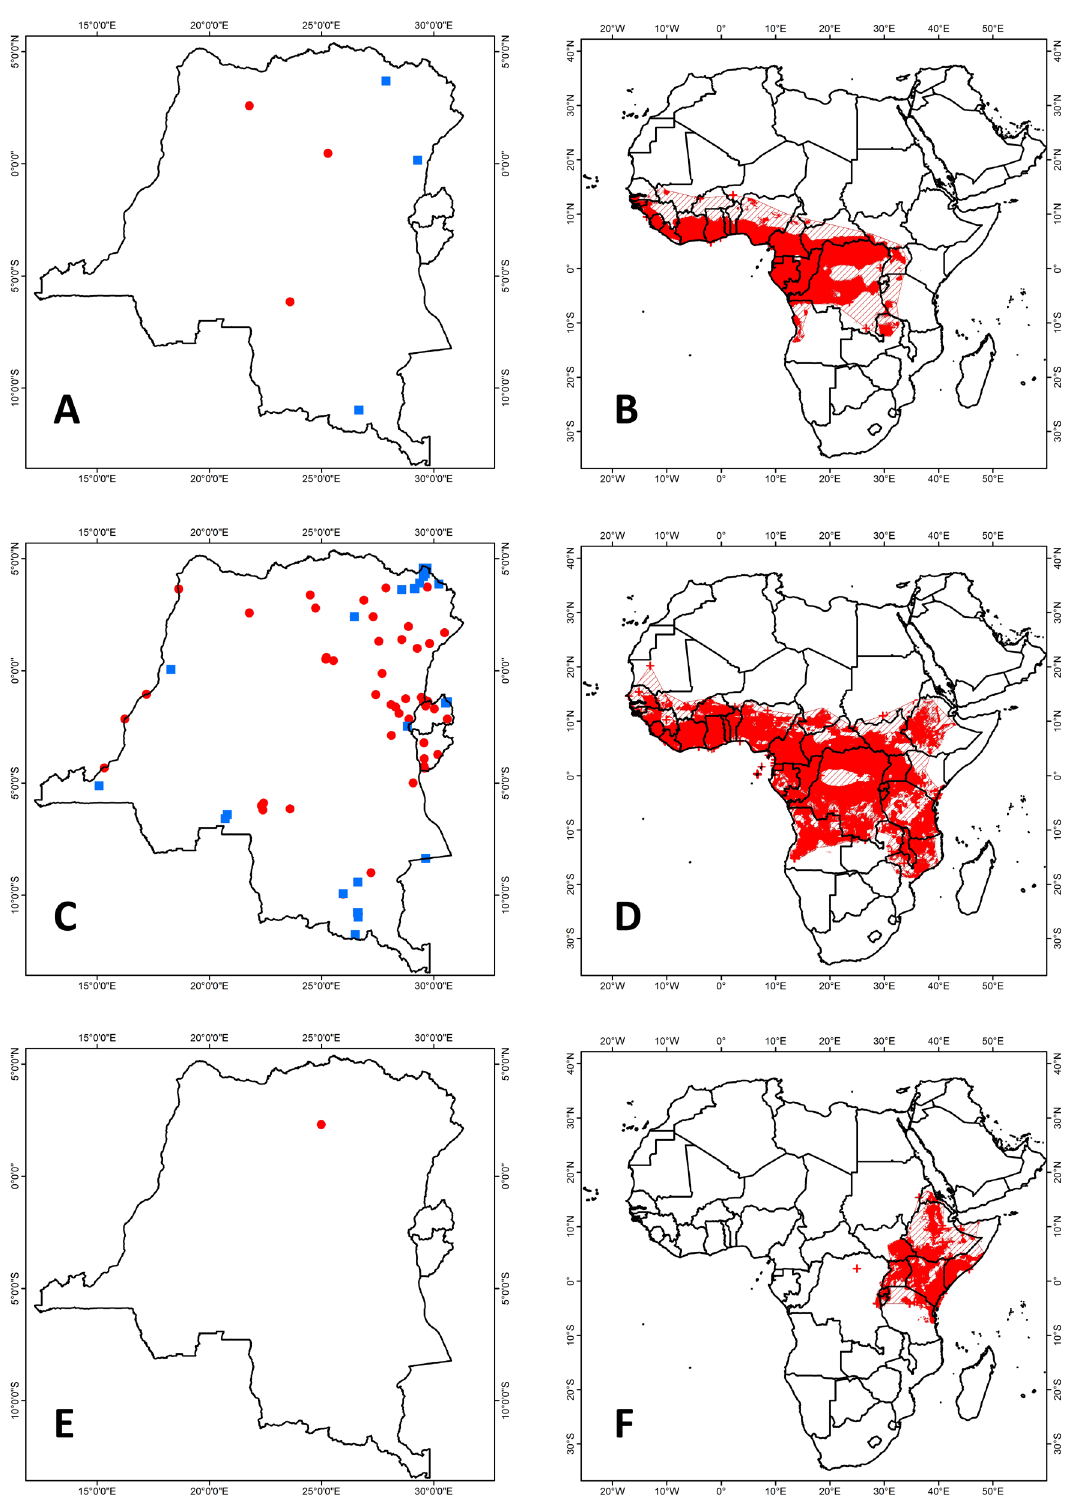
Fig. 13. Distribution maps. A–B . Macronycteris gigas (Wagner, 1845). C–D . Macronycteris vittatus (Peters, 1852). E–F . Cardioderma cor (Peters, 1872). A, C, E. Distribution in the CRB area. B, D,